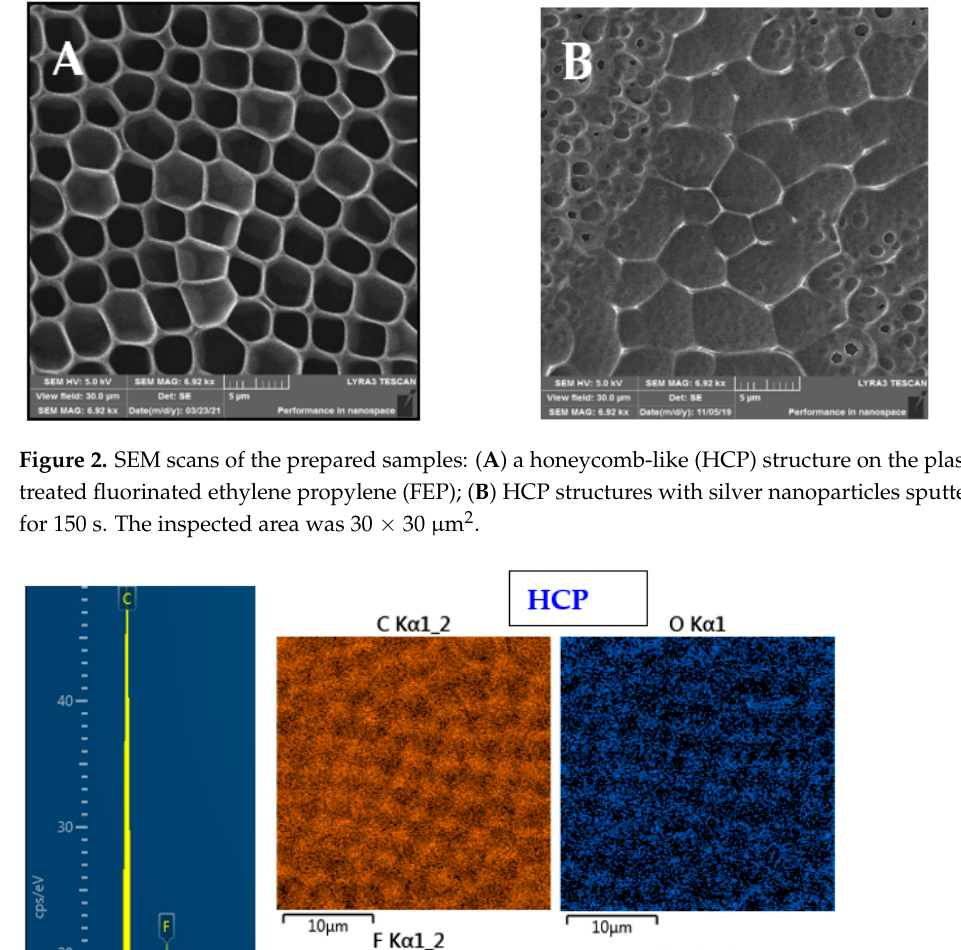
Figure 4. EDS spectrum and elemental maps with layered EDS images for the honeycomb-like (HCP) structure containing polyethylene glycol (PEG) with sputtered Ag on the plasma-treated fluorinated ethylene propylene (FEP).